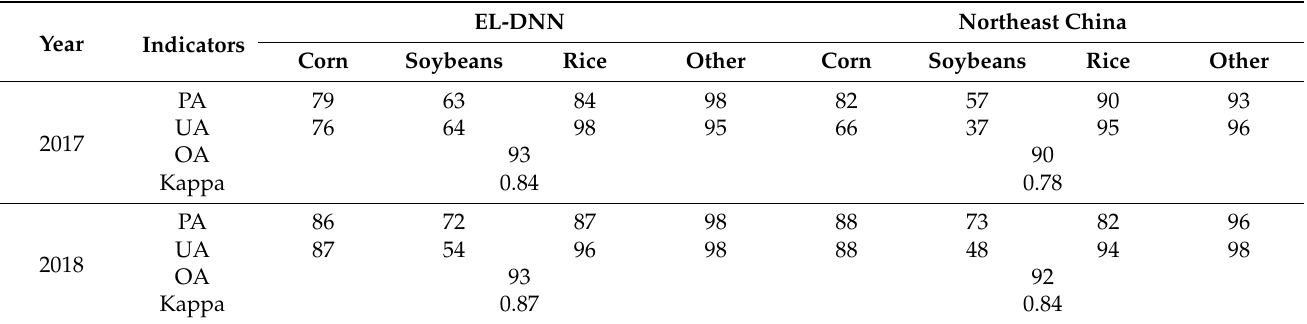
Table 5. Comparison of EL-DNN and Northeast China products for various types of PA (%), UA (%), OA (%), and Kappa coefficients.